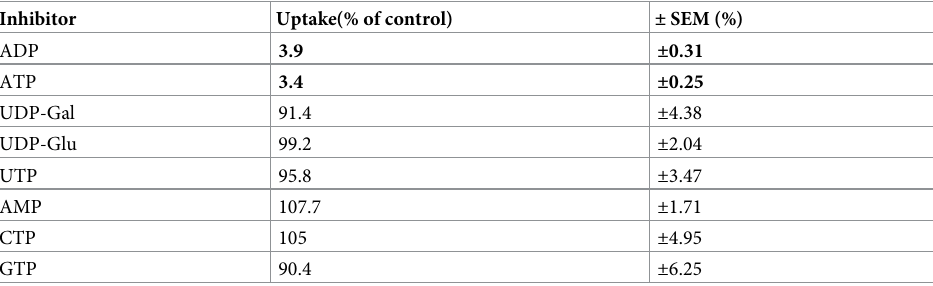
Table 1. Impact of potential substrates and effectors on ATP transport by